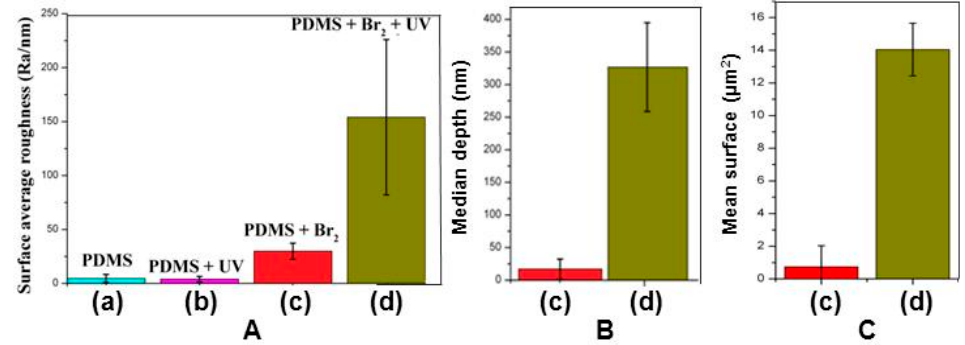
Figure 11. ( A ) Average surface roughness, R a . ( B ) Mean well depth for the bromide-treated samples. ( C ) Mean surface area of wells. The dispersions of four replicated samples (considering three images per sample) are indicated by segments on each bar.